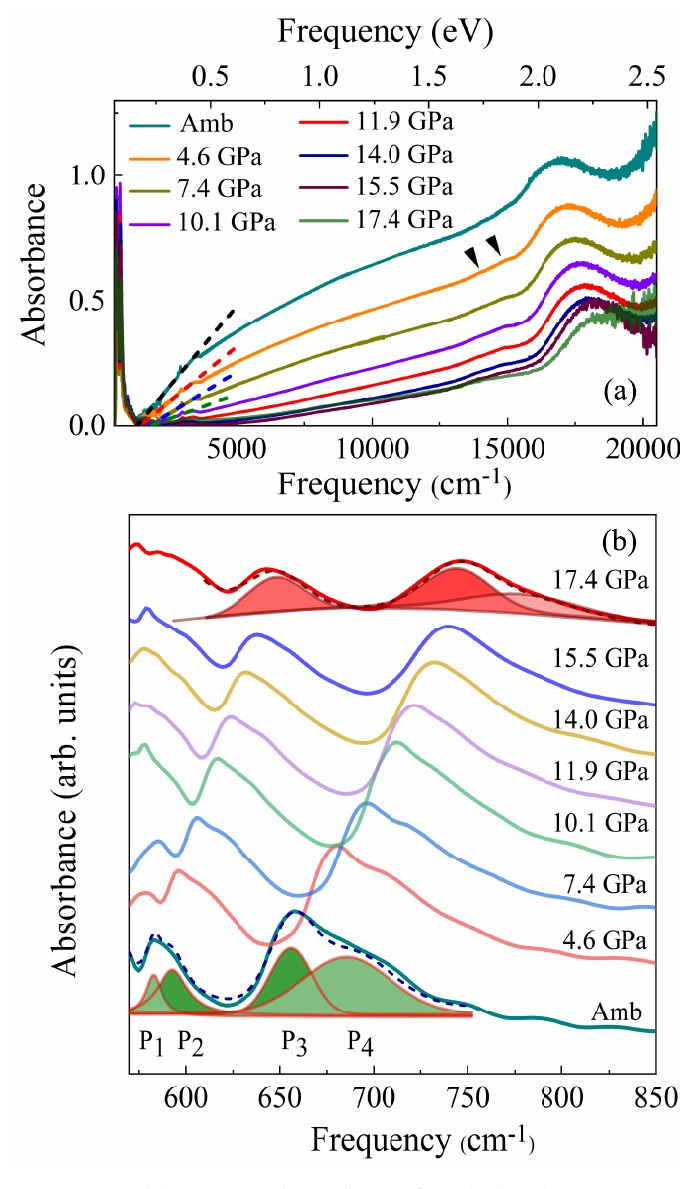
Figure 11. ( a ) Pressure-dependent infrared absorbance spectra in a broad frequency range 500–20,500 cm − 1 . The two weak features indicated by black arrows are due to spin-forbidden crystal field excitations. ( b ) Low-frequency absorbance spectra with phonon modes (labelled P1–P4) as a function of pressure, fitted with Lorentz